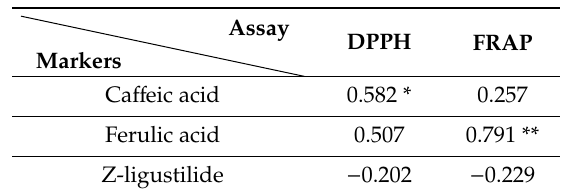
Table 4. Pearson correlation between the three chemical markers and antioxidant activities of the samples in the DPPH and FRAP